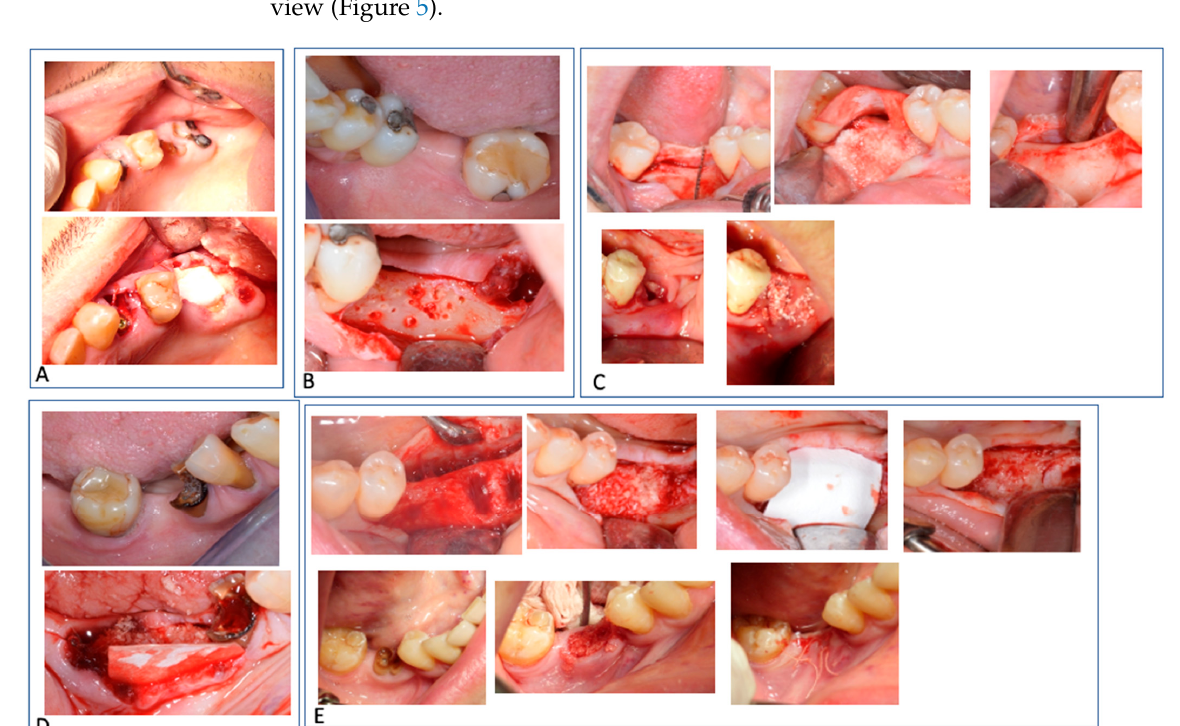
Figure 5. Images of all cases. Cases ( A – E ), the groups 1 and 2 are in different mouth sites. Histomorphometric preliminary results demonstrated a significant amount of vital bone (Group 1: 38.42 ± 4.58 vs. Group 2: 9.75 ± 11.81) and bone volume (Group 1: 45.69 ± 2.31 vs. Group 2: 37.34 ± 6.33) in the case of membrane-associated ridge